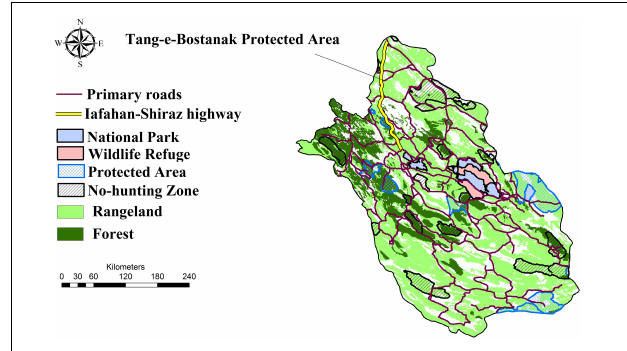
FIGURE 3 | Location of forests, rangelands, protected areas, primary roads, and the Isfahan-Shiraz highway in Fars province.